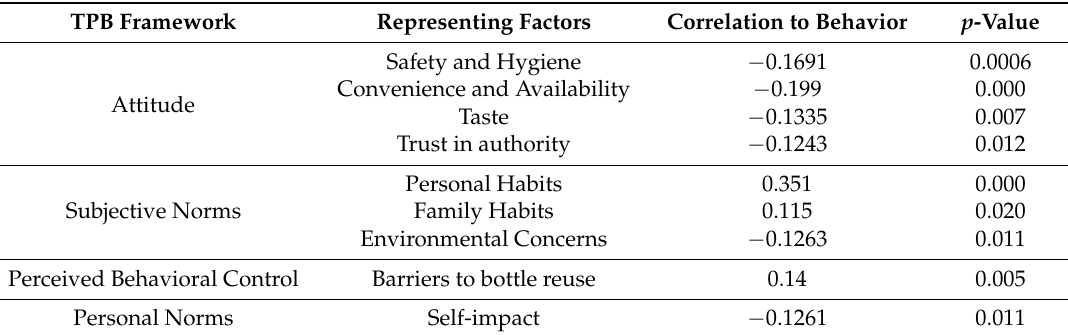
Table 5. Correlations tested in the TPB